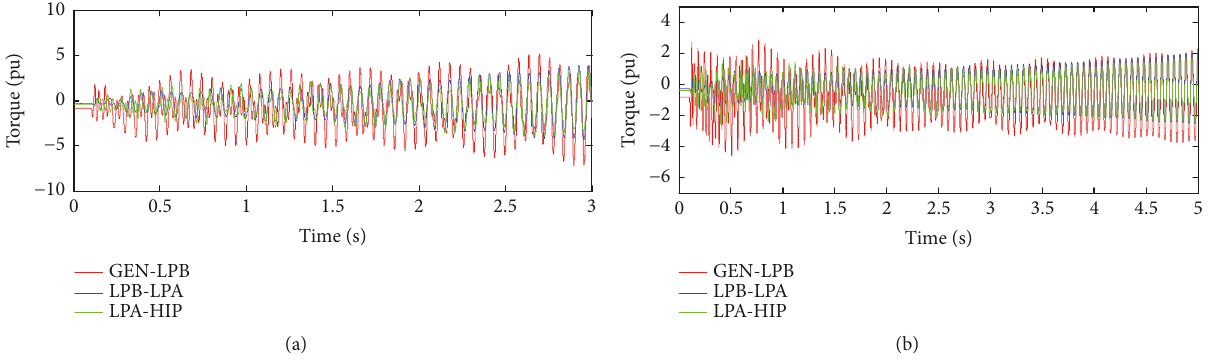
Figure 8: The torsional torque in GEN-LPB, LPA-LPB,and LPA-HIP shaft sections: (a) Vungang I plant’s unit 1 during and after clearing fault and (b) Vungang II plant’s unit 1 during and after clearing fault.